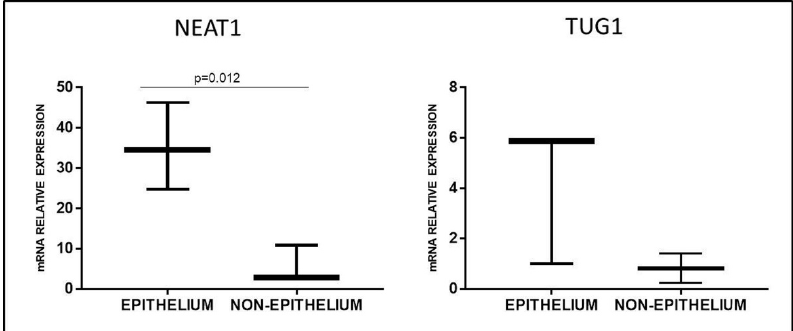
Figure 5. NEAT1 and TUG1 mRNA expression in epithelial or non-epithelial fraction of healthy duodenal mucosa obtained by laser microdissection ( n = 3). Data are expressed as box plots indicating 25–75th percentile and median value, with whiskers representing 5th and 95th percentile.